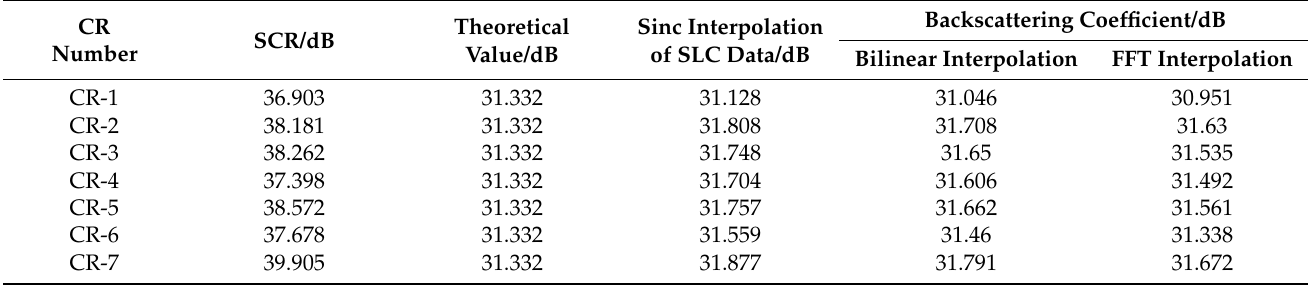
Table 3. SCR and RCS calculated for different interpolation methods.